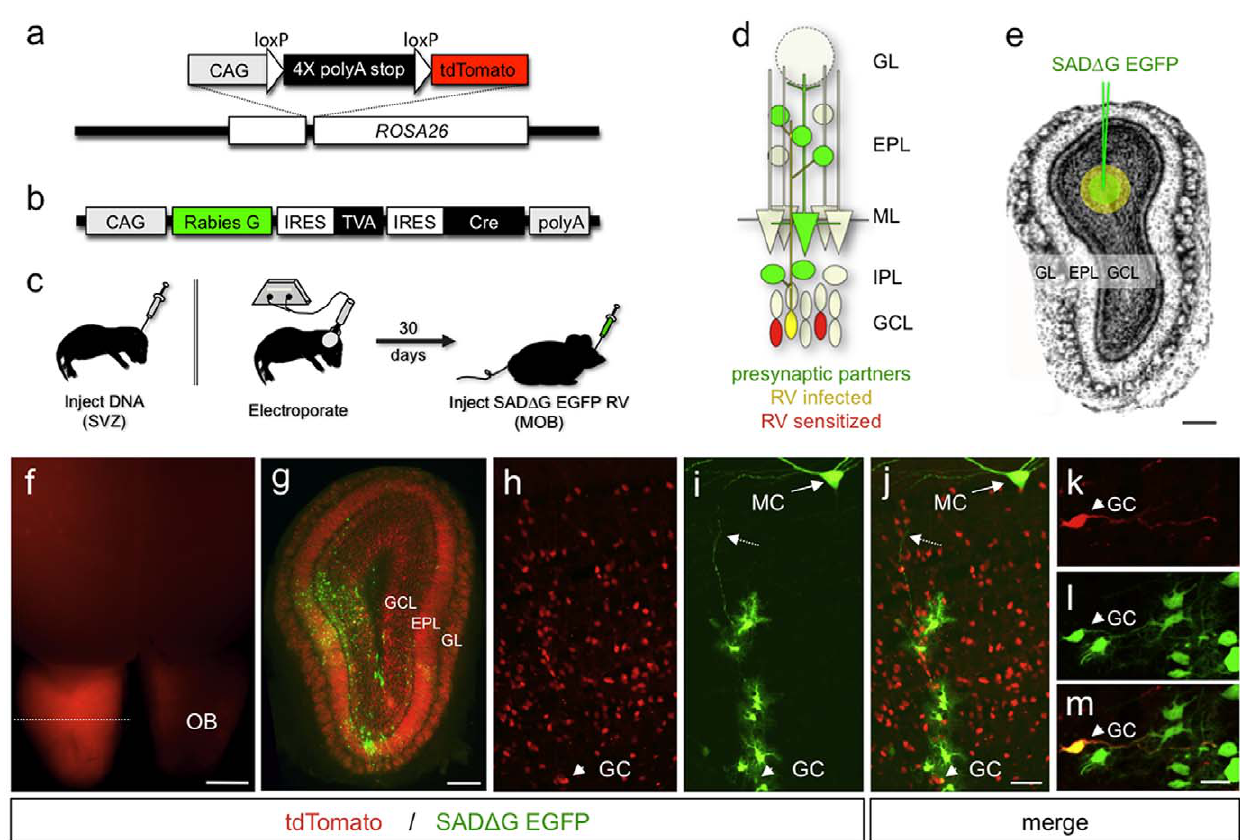
Figure 1. Engineered Rabies Virus Allows Monosynaptic Circuit Tracing in Olfactory Bulb. (a) Illustration of the ROSA26-stop flox -tdTomato conditional knock-in allele. (b) Illustration of the tri-cistronic G-IRES-TVA-IRES-Cre expression construct used for electroporation into the subventricular zone (SVZ) of ROSA26-stop flox -tdTomato mice. (c) Illustration of the in vivo electroporation procedure. Left, plasmid DNA encoding G- IRES-TVA-IRES-Cre was injected into the lateral ventricle of newborn mice. Middle, a square-pulse voltage was applied across the head to introduce the expression construct into SVZ progenitors. Right, 30 d following electroporation, pseudotyped SAD D G-EGFP RV was injected into the olfactory bulb for targeted infection of electroporated granule cells. (d) Diagram showing how pre- and postsynaptic neurons can be identified by two-color monosynaptic viral tracing in the conditional ROSA26-stop flox -tdTomato background. Red cells represent conditional tdTomato reporter expression following G-IRES-TVA-IRES-Cre electroporation. Yellow cells represent electroporated cells that are also infected by SAD D G-EGFP RV. Green cells represent presynaptic targets of the infected granule cells. GL, glomerular layer; EPL, external plexiform layer; ML, mitral cell layer; IPL, internal plexiform layer; GCL, granule cell layer. (e) Schematic illustrating the estimated domain of SAD D G-EGFP RV infection with respect to the entire bulb. On average, infected granule cells were detected within 302 m m of the injection site (green circle) 6 214 m m (yellow outer circle). Scale bar, 300 m m. (f) Whole mount view of ROSA26-stop flox -tdTomato mouse brain 30 d after unilateral G-IRES-TVA-IRES-Cre electroporation. Dashed line represents the coronal section imaged in (g)–(i). OB, olfactory bulb. Scale bar, 1 mm. (g) Coronal section through an electroporated and infected olfactory bulb showing tdTomato and SAD D G-EGFP expression. Scale bar, 300 m m. (h) Coronal section through the olfactory bulb of electroporated mice showing tdTomato-expressing granule cells at higher magnification. (i) Section shown in (h) imaged for SAD D G-EGFP following RV infection. (j) Merged view of (h) and (i). MC, mitral cell; GC, granule cell origin; dashed arrow, granule cell dendrite. Scale bar, 25 m m. (k)–(m) Dual tdTomato plus SAD D G-EGFP reporter expression, identifying a local granule cell microcircuit. (k) tdTomato expression in a single granule cell. (l) SAD D G-EGFP expression in the same ‘source’ granule cell shown in (k) and local presynaptic partners. (m) Merged reporter expression delineating source cell (yellow) and the local presynaptic partners (green). Short arrows in (k–m) point to the source granule cell. Scale bar, 10 m m.